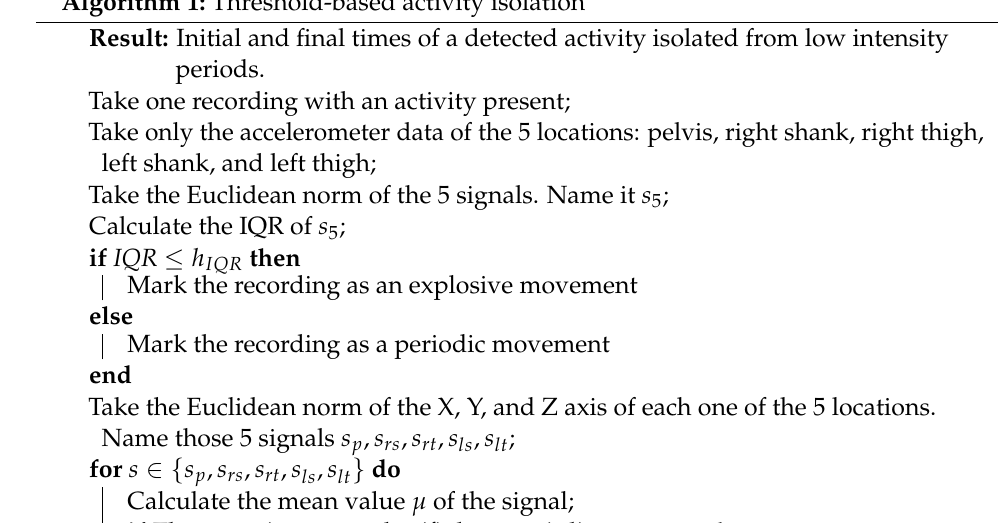
Algorithm 1: Threshold-based activity isolation